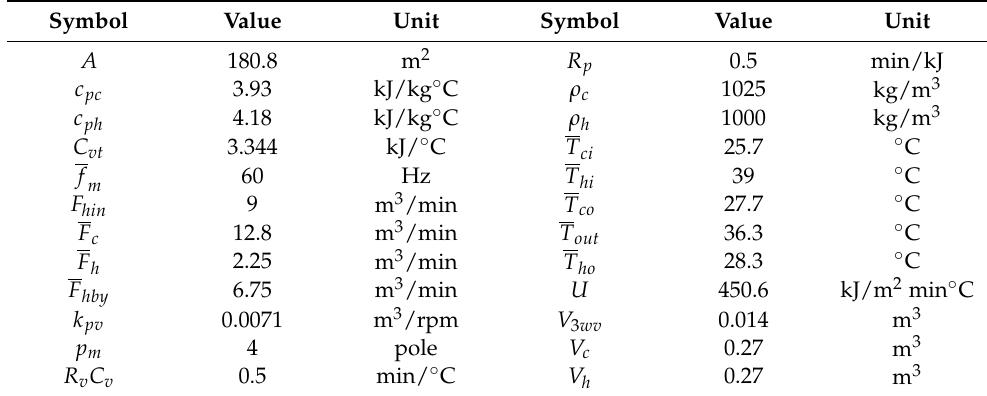
Table 3. Parameters of central cooling